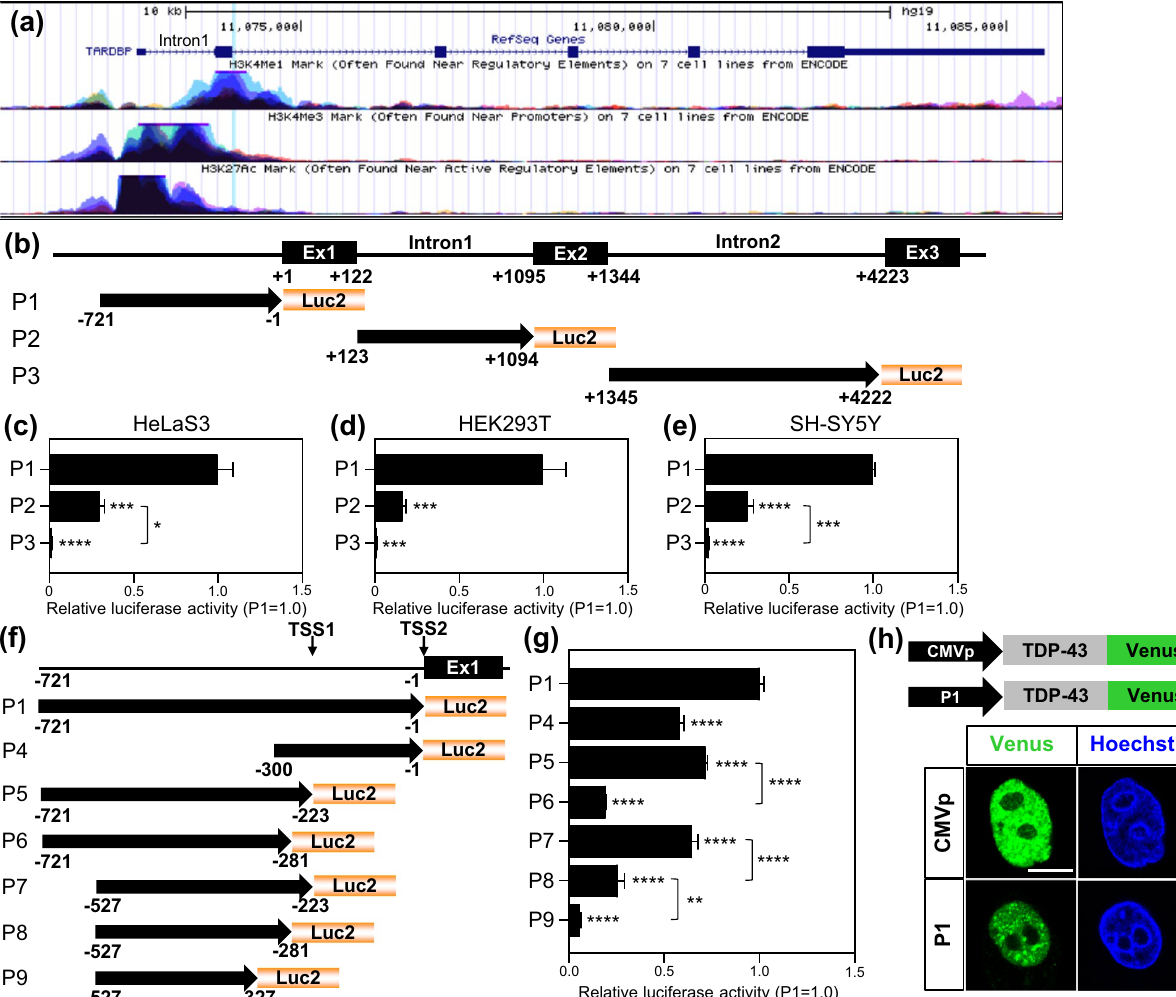
Figure 2. The TARDBP upstream region exhibits promoter activity. ( a ) Epigenetic marker activity in the human TARDBP region in 7 cell lines from ENCODE is exhibited by the UCSC genome browser. H3K4me1 (often found near regulatory elements), H3K4me3 (often found near promoters) and H3K27ac (often found near active regulatory elements) are described. The TARDBP genomic position is chr1:11072679–11085549 in GRCh37/hg19, and the gene accession code from NCBI is NM_007375. ( b ) Schematic representation of the TARDBP upstream promoter and intron/Luc2 constructs (P1–3). The black boxes and lines indicate exons (Ex) and introns, respectively. + 1 indicates TSS2 (see Fig. 1). P1 (− 721/− 1), P2 (+ 123/ + 1094, intron 1), and P3 (+ 1345/ + 4222, intron 2). ( c – e ) TARDBP promoter/luciferase assay in 3 cell lines: HeLaS3 ( c ), HEK293T ( d ) and SH-SY5Y ( e ). n = 3 replicates; one-way ANOVA with post hoc Tukey’s test relative to P1. ( f ) Schematic representation of TARDBP promoter constructs (P4–9). P4 (− 300/− 1), P5 (− 721/− 223), P6 (− 721/− 281), P7 (− 527/− 223), P8 (− 527/− 281), and P9 (− 527/− 327). ( g ) Luciferase assay of TARDBP promoter fragments. Quantitative analyses have n = 9 (P1), n = 6 (P7) and n = 3 (P4, P5, P6, P8 and P9) replicates. One-way ANOVA with post hoc Tukey’s test was used, and all error bars indicate the means ± SEMs. ** P < 0.01, *** P < 0.001, **** P < 0.0001. ( h ) Fluorescence images of TDP-43-Venus (Green) expression driven by the CMV promoter (CMVp) or TARDBP upstream promoter (P1) in HeLaS3 cells. Nuclei were stained with Hoechst (blue). Scale bar 10